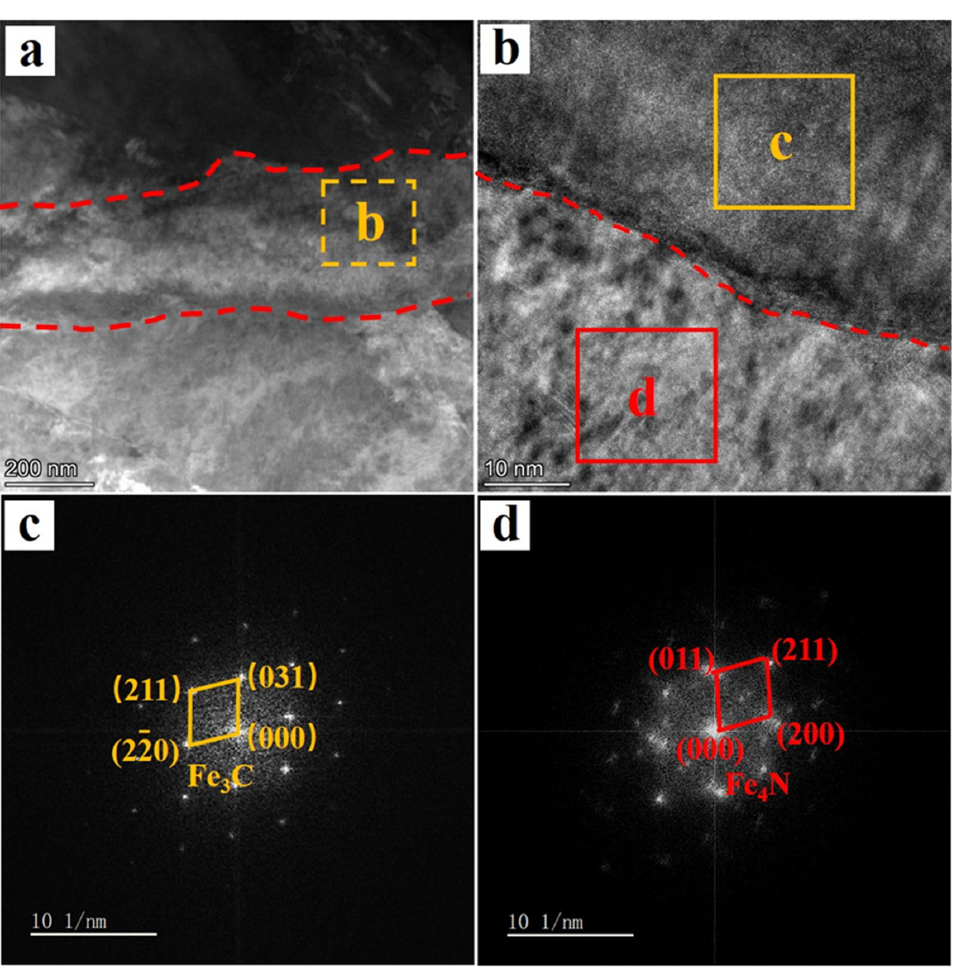
Figure 10. ( a ) TEM image of the VLGB tissue in the C + N state diffusion layer; ( b ) high-resolution images of the marked sites in ( a ); ( c , d ) correspond to the marked positions in ( b ).